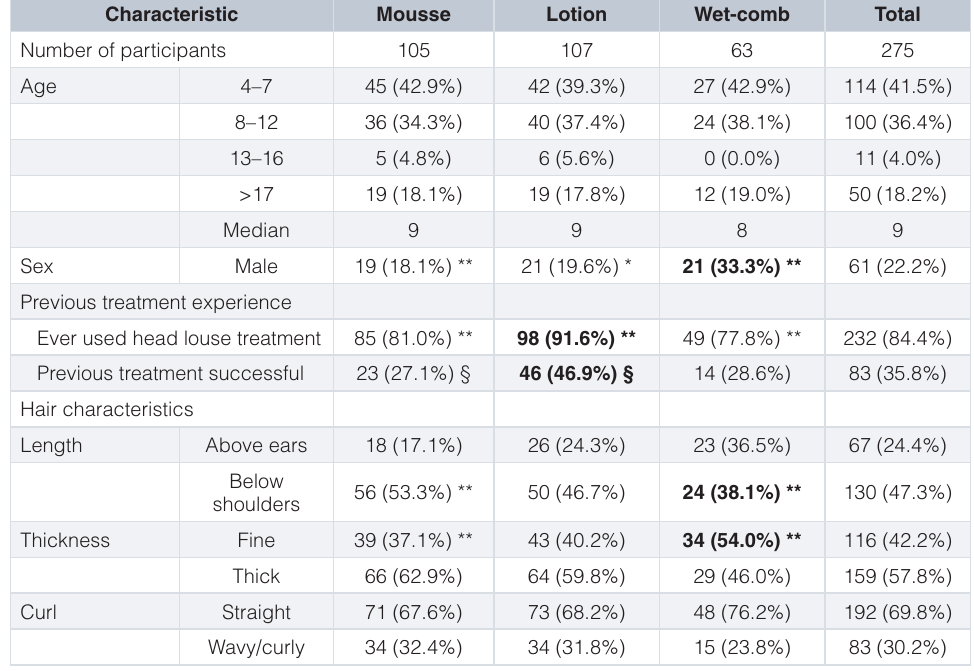
Table 1. Demographic characteristics of the intention to treat